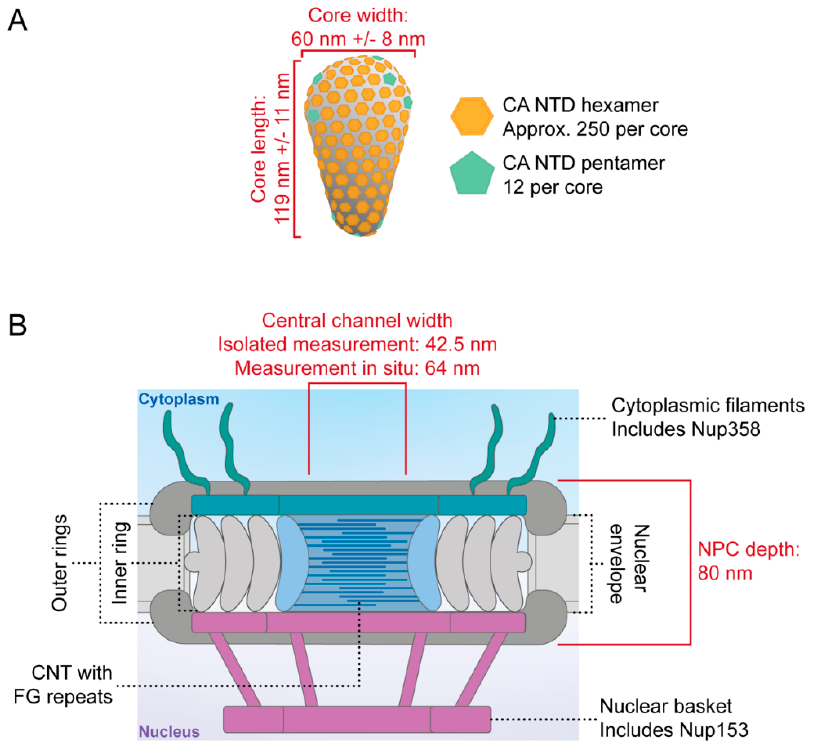
Figure 1. The HIV-1 core and the human NPC. ( A ) Diagram illustrating how CA assembles to form the fullerene shape of the HIV-1 core, where CA N-terminal domain hexamers are shown in orange and CA N-terminal domain pentamers are shown in green. Core measurements shown in red are taken from [7]. ( B ) Diagram of the human NPC highlighting relevant features, labelled with dashed lines. Pore measurements shown in red are taken from [35,36]. CNT = channel nucleoporin heterotrimer; FG repeats = phenylalanine-glycine repeats.